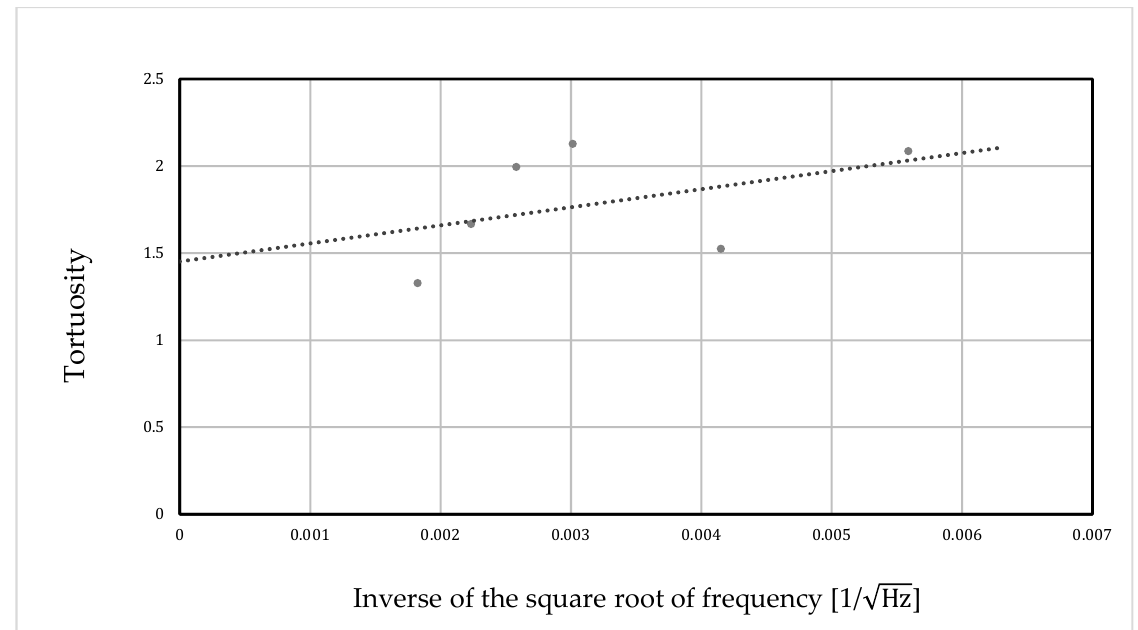
Figure 4. Results of the tortuosity measurements.